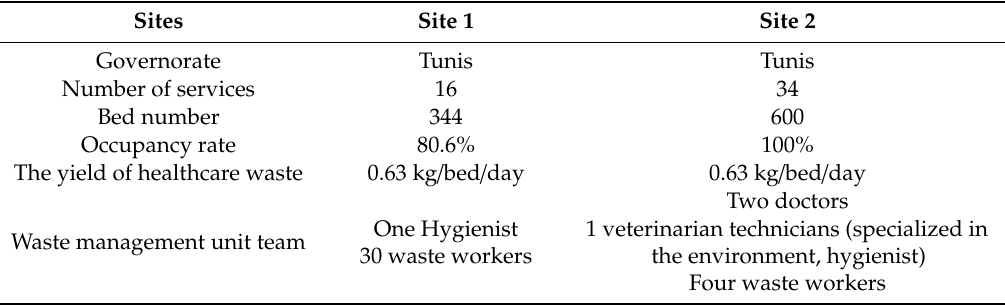
Table 1. The study